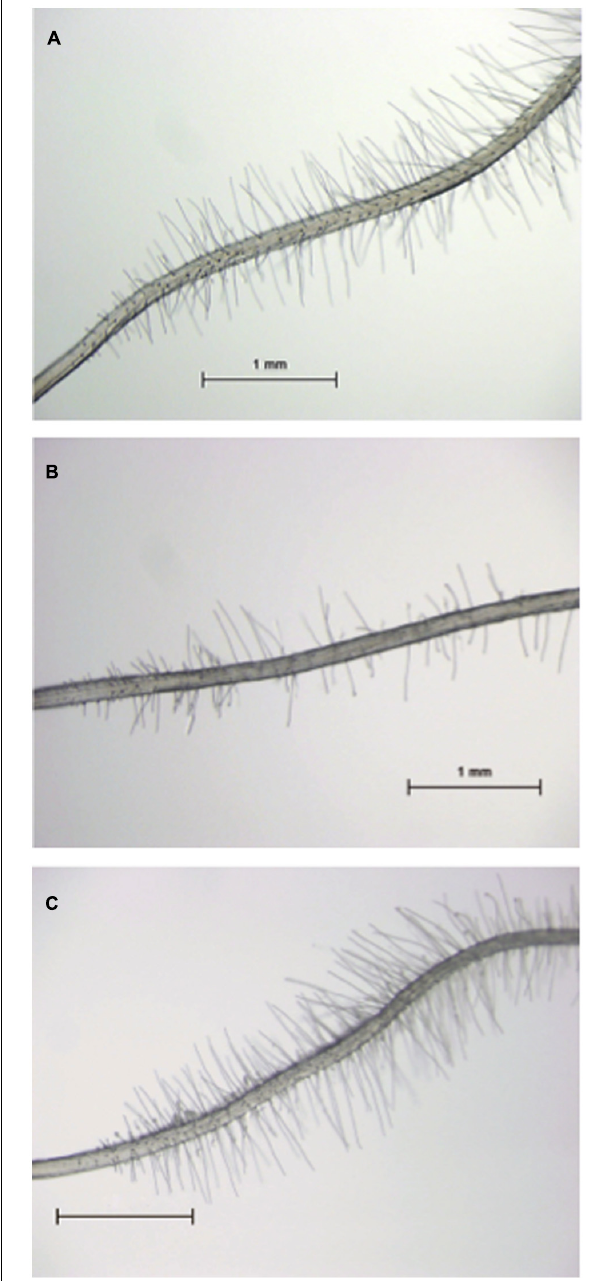
FIGURE 2 | Root-hair phenotype of CPC :: SlTRY transgenic plants. (A) Root-hair phenotype of a 5-day-old Arabidopsis wild type (Col-0) seedling. (B) Root-hair phenotype of a 5-day-old Arabidopsis cpc-2 mutant seedling. (C) Root-hair phenotype of a 5-day-old Arabidopsis cpc-2 mutant seedling transformed with CPC :: SlTRY . Scale bars: 1